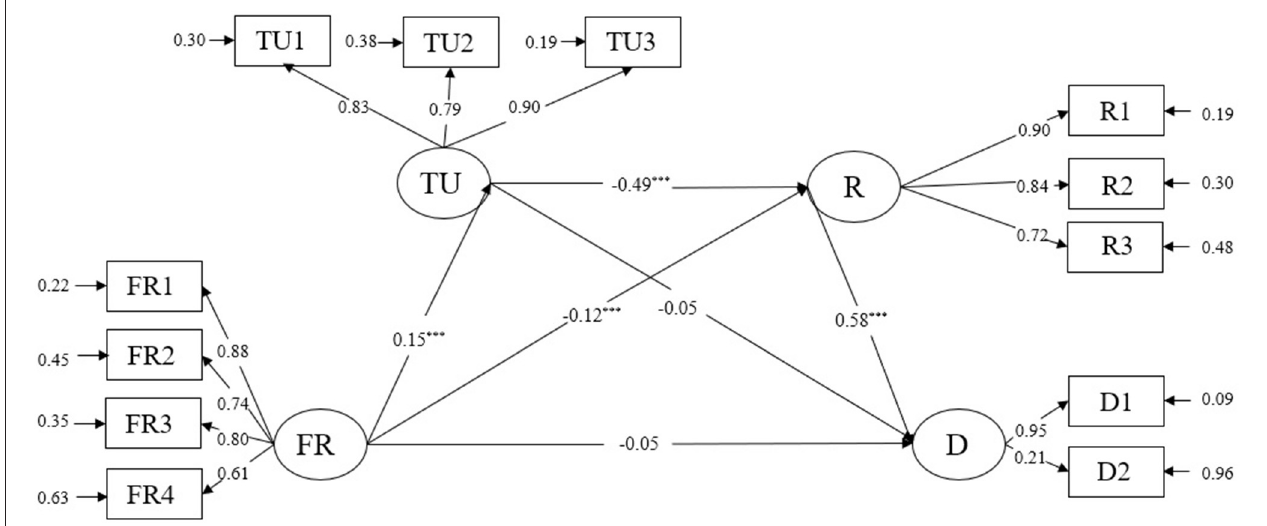
FIGURE 2 | The standardized path coefficients in model testing. FR, Family Routines; TU, Tolerance of Uncertainty; R, Rumination; D, Depression. *** p <